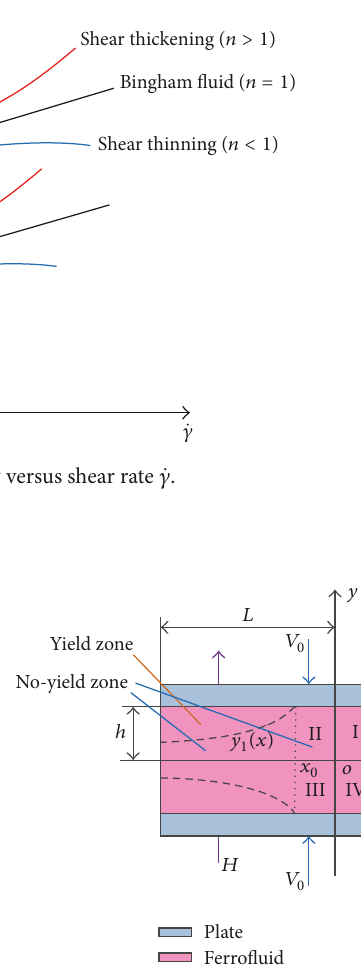
Figure 4: Diagram of parallel symmetric squeeze flow of